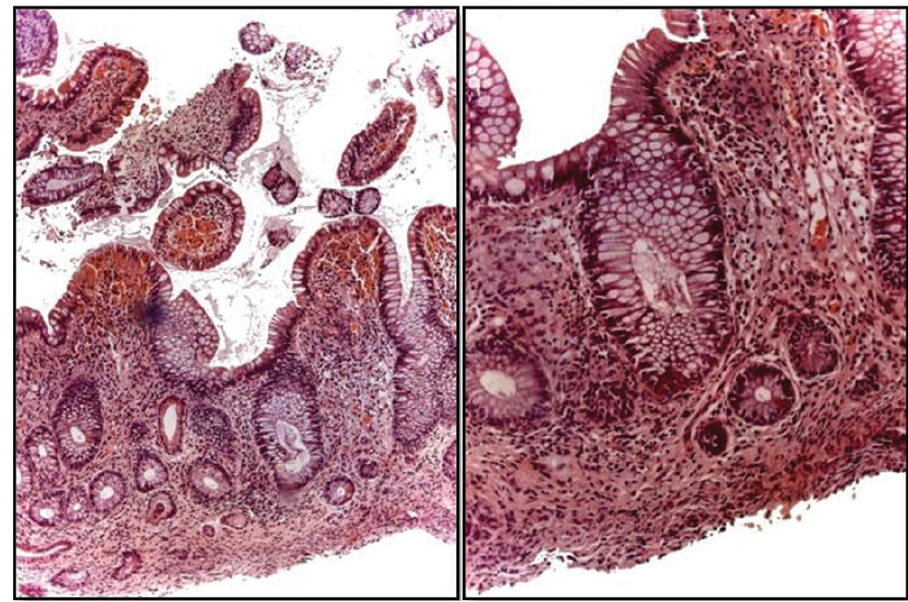
Figure 2 - Mucosal atrophy, where villous: crypt ratio is 1:1. Enlargement of the villi, Lymphocytic predominance and lamina propria’s fibroplasia.